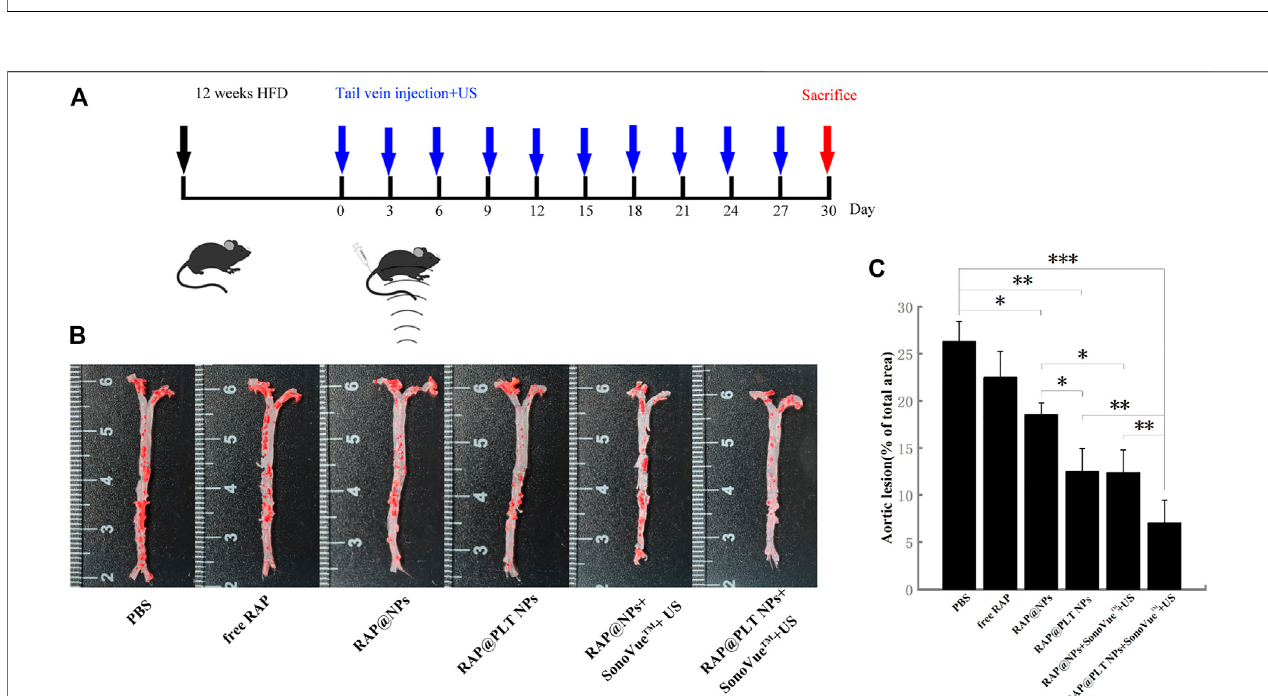
FIGURE4| TheFluorescenceimagingoftheaorta. (A) The invivo fl uorescenceimagesoftheaorta. (B) quantitativedataof fl uorescencesignalsaccumulatedinthe aorta of ApoE − / − mice after treatment of PBS, IR780-labeled RAP@NPs, RAP@PLT NPs, RAP@NPs + SonoVue ™ + US and RAP@PLT NPs + SonoVue ™ + US. n = 3, mean ± SD, * p < 0.05 and *** p < 0.001.